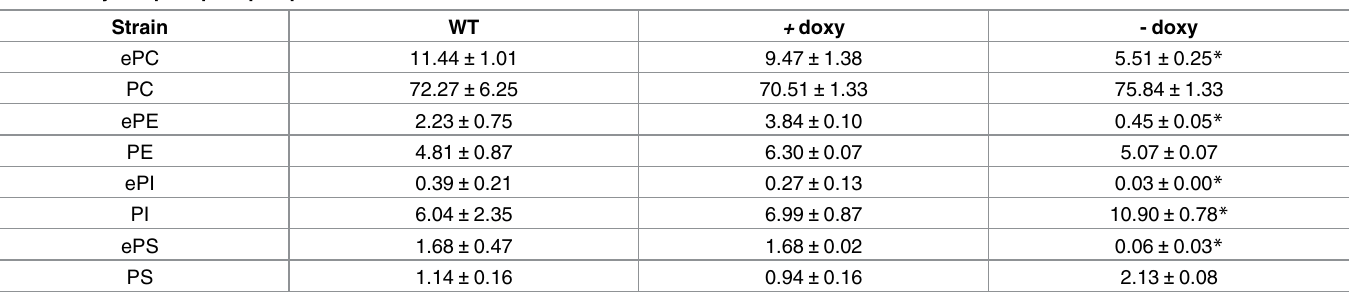
Table 1. Glycerophospholipid quantification. Strain